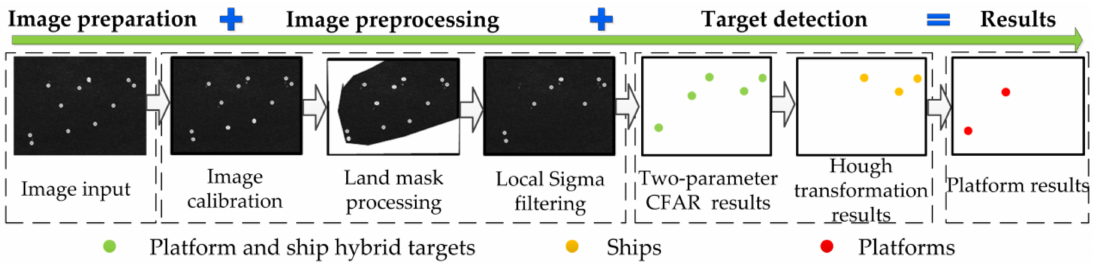
Figure 4. A schematic diagram of the automatic extraction process of an offshore platform.